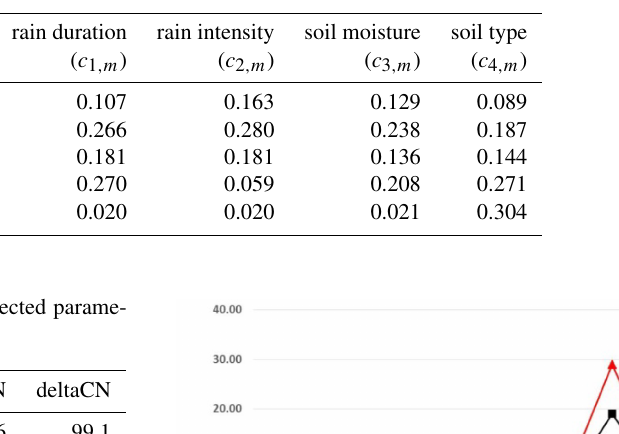
Table 2. Model consequent coefficients from shuffled evolution calibration.